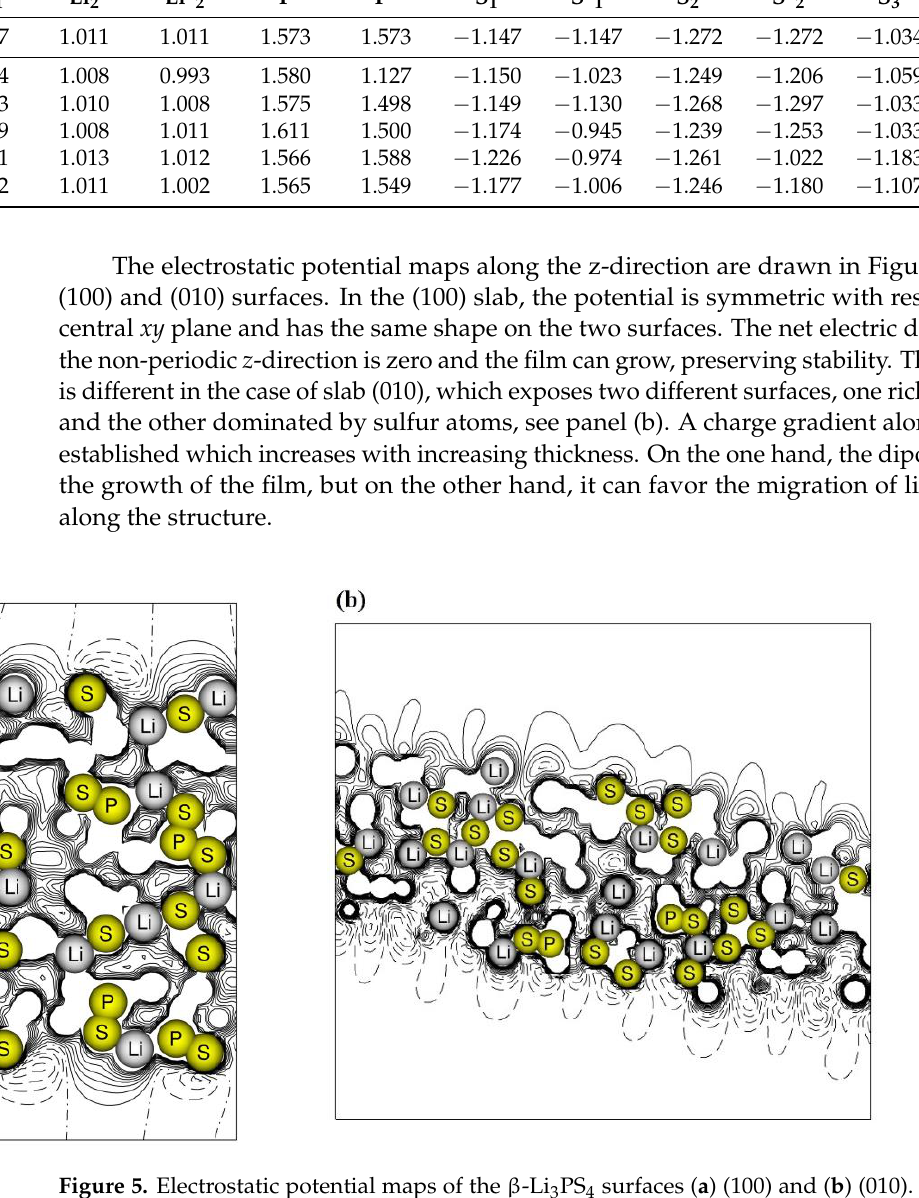
Figure 5. Electrostatic potential maps of the β -Li 3 PS 4 surfaces ( a ) (100) and ( b ) (010). Continuous and dashed lines for positive and negative values of the potential.